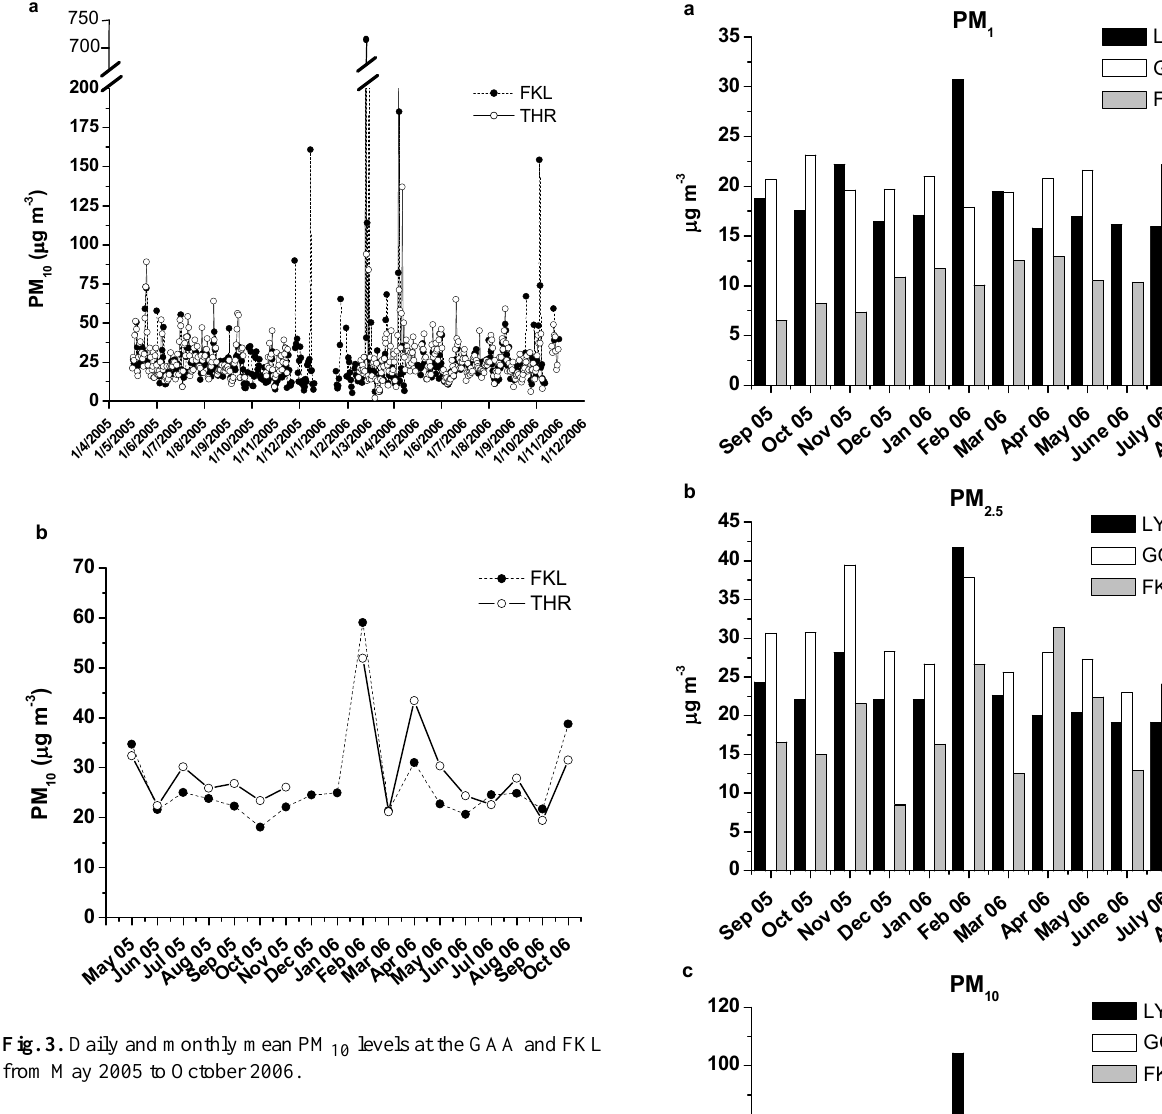
al., 2006; Karageorgos and Rapsomanikis, 2007, Table 2).